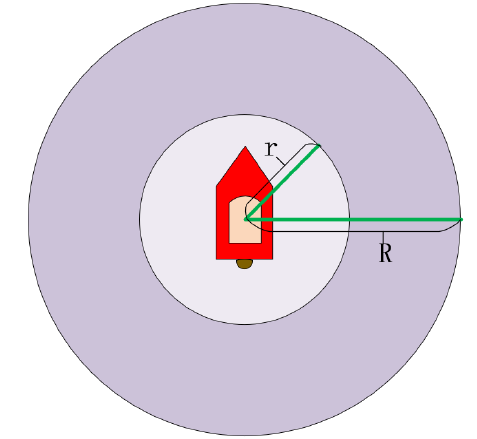
Figure 3. Ship domain and dynamic area.